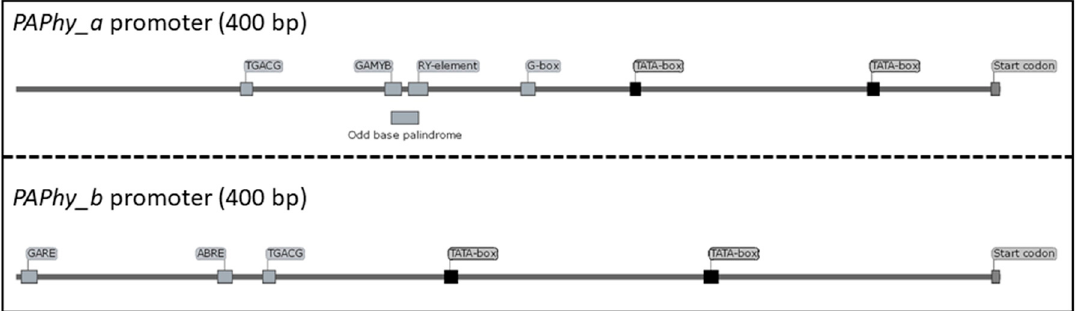
Figure 2. Consensus promoters of PAPhy_a and PAPhy_b , respectively, showing the most conserved cis-acting regulatory elements.